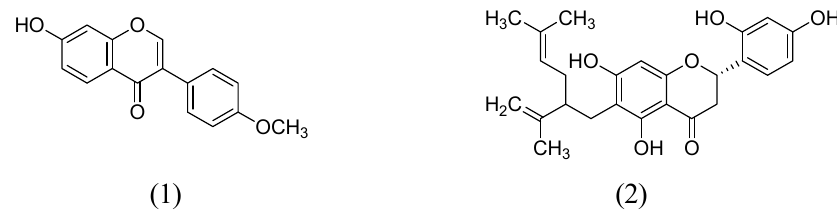
Figure 2. Structures of Formononetin ( 1 ) and Kushenol F ( 2 ).